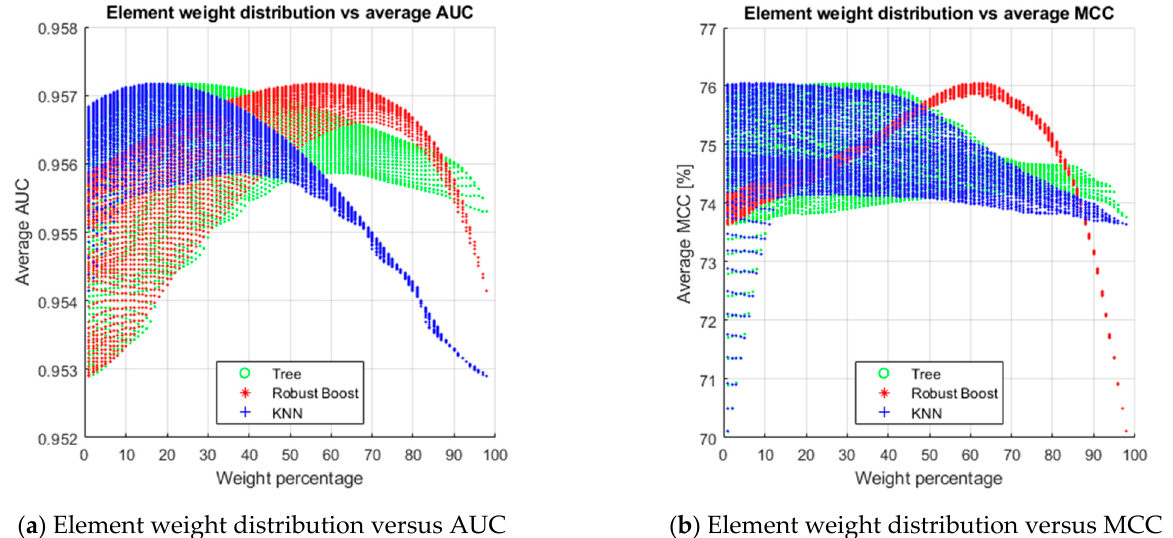
Figure 5. Summary of iteration of the element weights components versus a five-fold average of selected performance metrics.